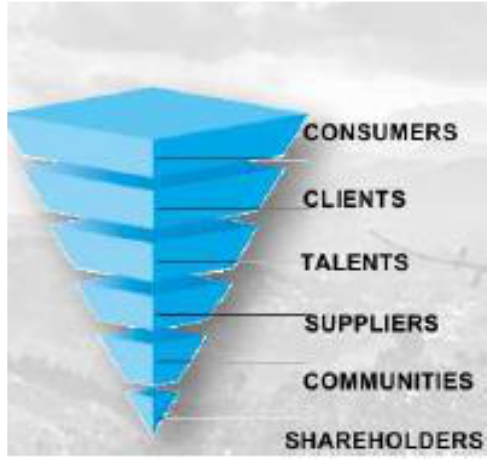
Figure 1: Illycaffè’s Stakeholder